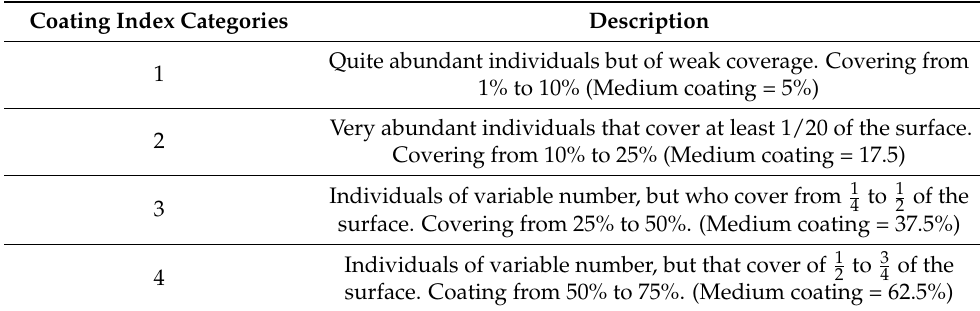
Table 1. Coating Index